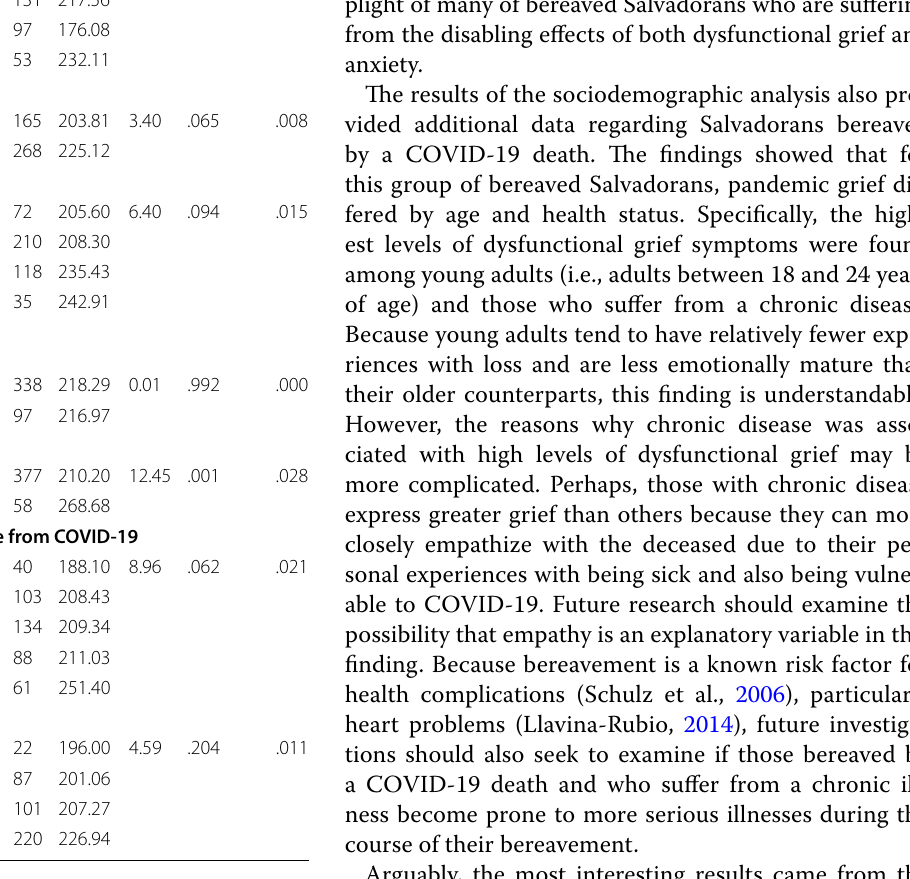
Table 4 Statistical differences in pandemic grief based on the sociodemographic variables of the sample ( n Sociodemographic variables